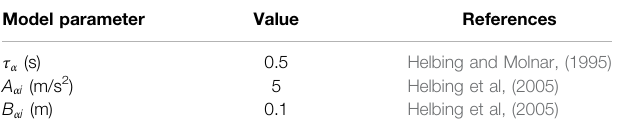
TABLE 1 | Fixed values of the social force model